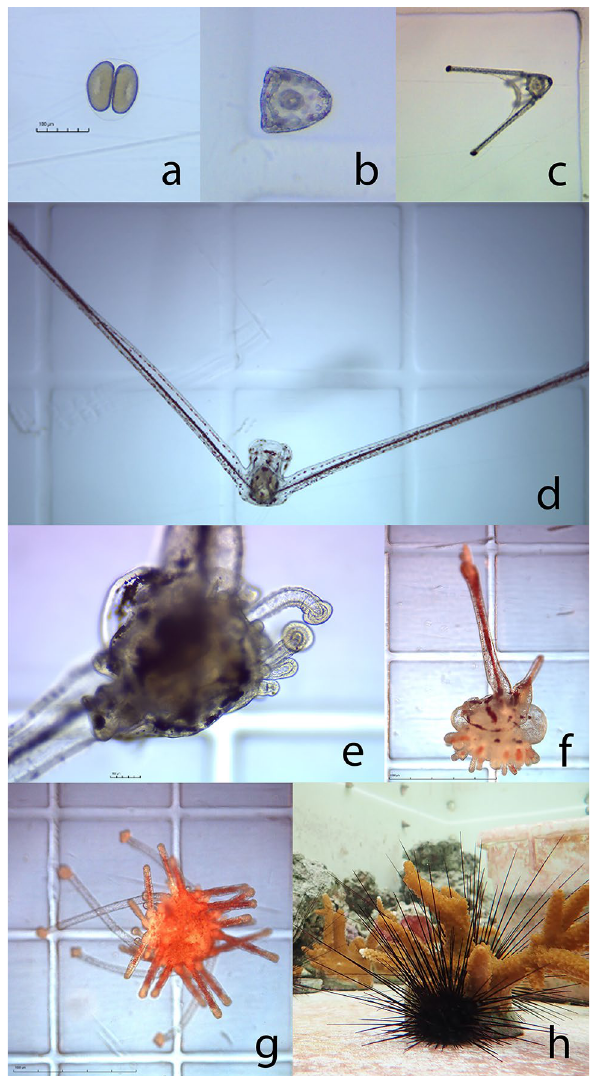
Figure 3. Representative photographs of D. antillarum development at ( a ) 2 h post fertilization, first cell division, D = 80 µm, ( b ) 36 h post fertilization, late gastrula/prism, mid body length (MBL) = 85 µm, ( c ) 3 d post fertilization, early pluteus larvae, MBL = 90 µm, appendage length (AL) = 190 µm, ( d ) 21 d post fertilization, 4-armed echinopluteus transversus larvae, MBL = 250 µm, AL = 2000 µm, ( e ) 28 d post fertilization, metamorphically competent late pluteus larvae with adult rudiment and extended tube feet, MBL = 600 µm, ( f ) 36 d post fertilization, mid-metamorphic radially symmetrical juvenile resorbing bilaterally symmetrical larval structure, D = 850 µm, ( g ) 36 d post fertilization, settled juvenile, D = 900 µm, ( h ) 248 d post fertilization, hatchery reared D. antillarum, D = 1–3